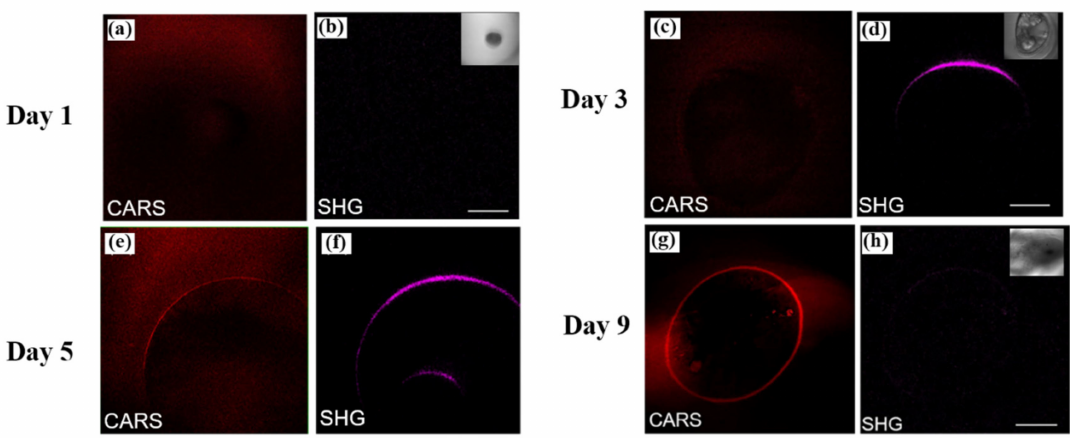
Figure 10. ( a , b ), ( c , d ), ( e , f ), ( g , h ) are the imaging results of CARS of snail bone elements and SHG of collagen on days 1, 3, 5, 9, respectively. Inset shows brightfield microscopy images of snail evolution on the corresponding day [55]. Republished with permission from Ref. [55]. Copyright 2022 John Wiley and